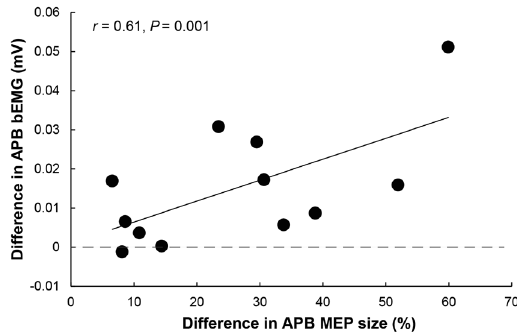
Figure 5. Shown are the attentional foci-related differences (IF–EF) of APB MEPs size during the premotor phase (related to control as percentage changes) on the abscissa and the differences (IF–EF) in APB bEMG during maximal contraction of the index finger on the ordinate. The robust regression model clearly demonstrates that greater decrease in bEMG found in the adjacent muscle APB during maximal contraction of the prime mover FDI (experiment 1) is accompanied by greater surround inhibition during the premotor phase in the adjacent APB (experiment 2, r = 0.61, P =